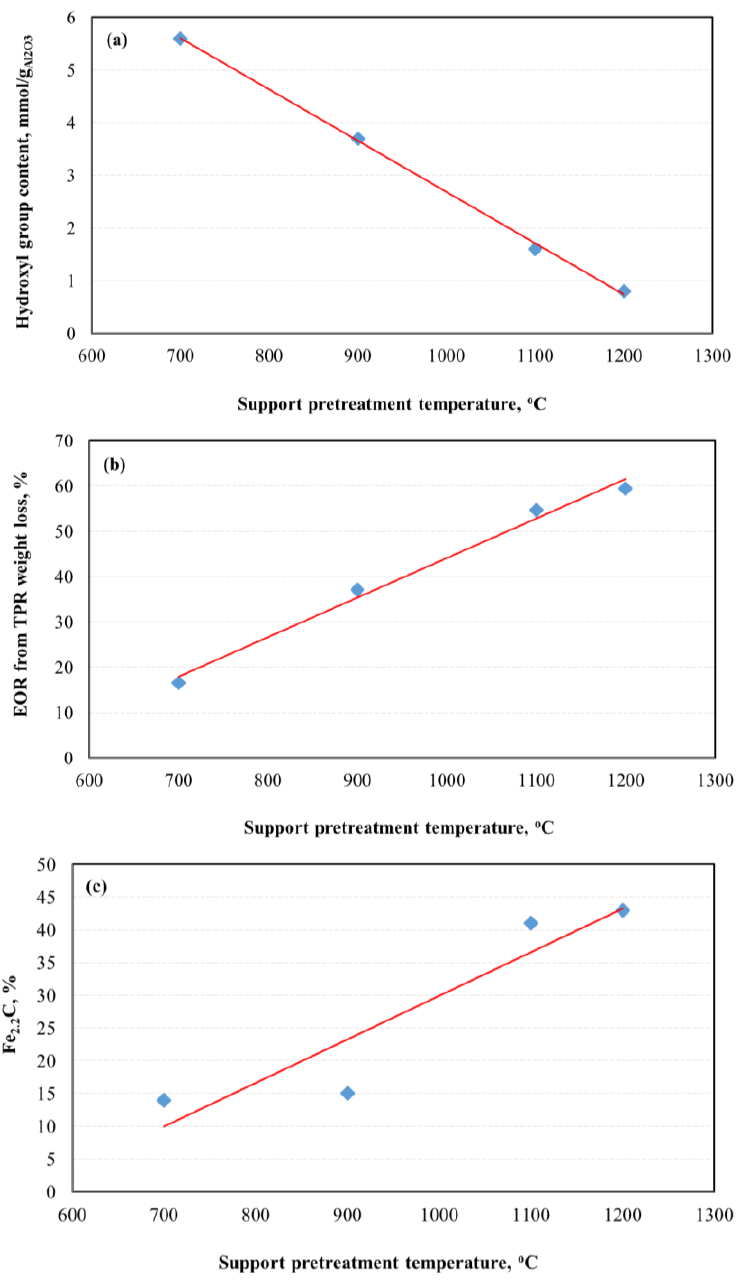
Figure 8. Correlation between support treatment temperature and ( a ) hydroxyl groups, ( b ) extent of reduction, and ( c ) iron carbide phase.